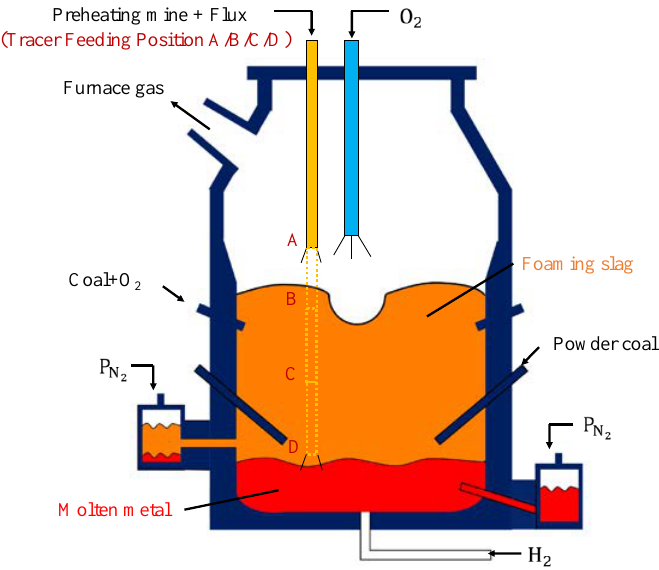
Figure 1. A new generation of C-H 2 iron bath smelting reduction process configuration.